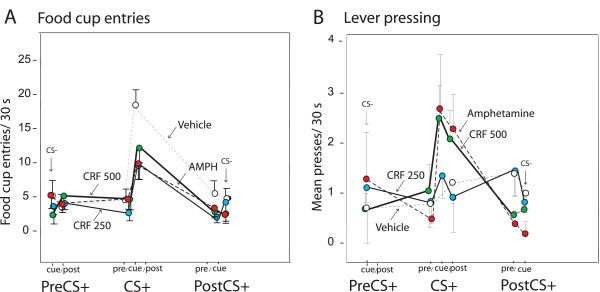
Response competition between sucrose dish approach and lever pressing. A. Averaged time-course of approach responses to sucrose dish just before, during and after first CS+ cue presentation. B. Same information for pressing on sucrose-associated lever. Each panel compares cue-triggered responding after microinjections of vehicle (white circles), CRF 500 μg (green circles), CRF 250 μg (blue circles), or amphetamine 20 μg (red circles). Both CRF and amphetamine reduced the peak of cue-triggered approaches to the sucrose dish, but simultaneously increased cue-triggered lever pressing. It is impossible to perform both actions at exactly the same time, and so conditioned dish approaches may have been suppressed as a result of response competition from increased lever pressing that occurred during the same 30-sec period.